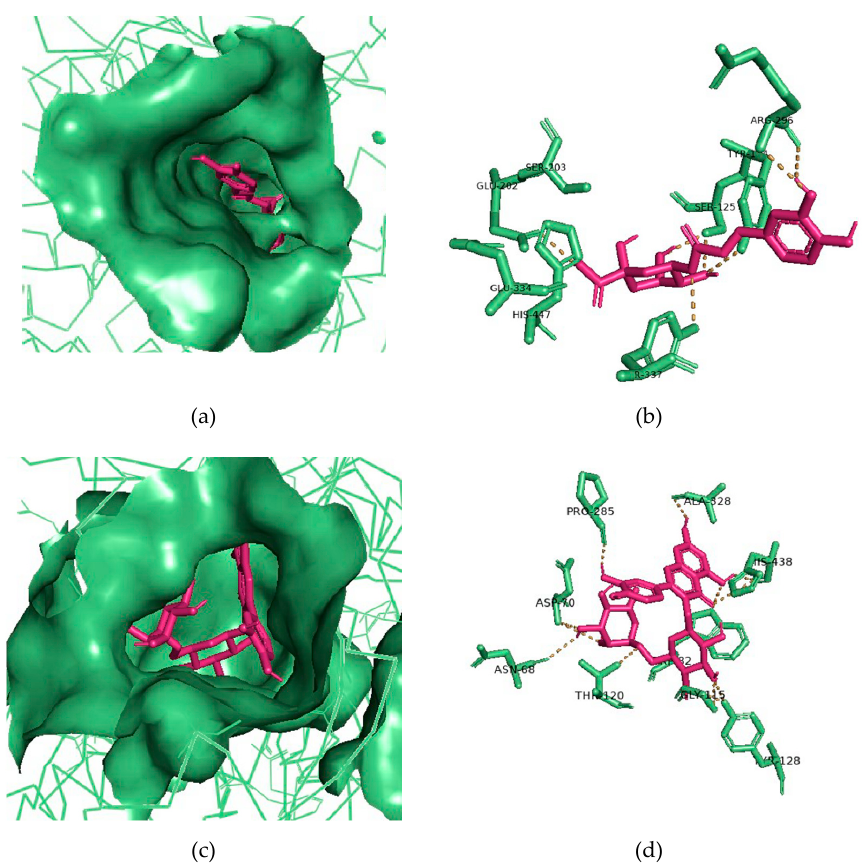
Figure 7. Molecular docking of potential ChEIs. ( a ) Binding pose of 3-caffeoylquinic acid (pink-colored sticks) looking down the gorge of AChE (green-colored surface representation). ( b ) The 3-caffeoylquinic acid (pink-colored sticks) docked with binding site residues of AChE (green-colored sticks). ( c ) Binding pose of rutin (pink-colored sticks) looking down the gorge of BuChE (green-colored surface representation). ( d ) Rutin (pink-colored sticks) docked with binding site residues of BuChE (green-colored sticks). Hydrogen bonding represented by yellow lines.